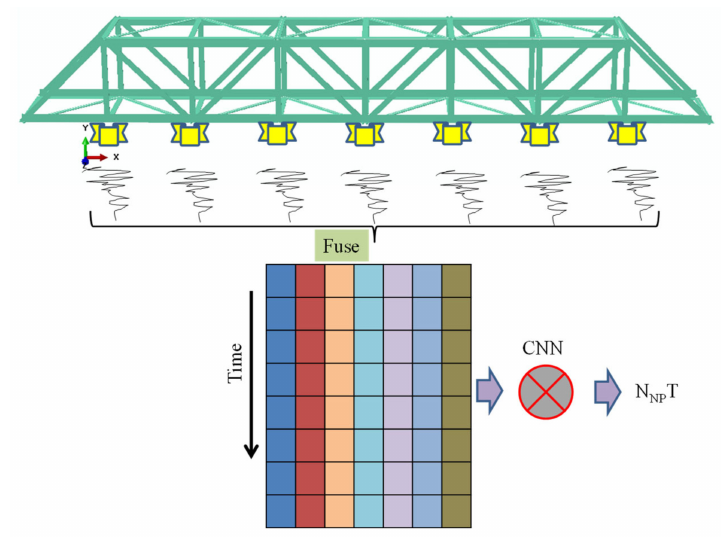
Figure 10. Implementation of the control experiment (data-level